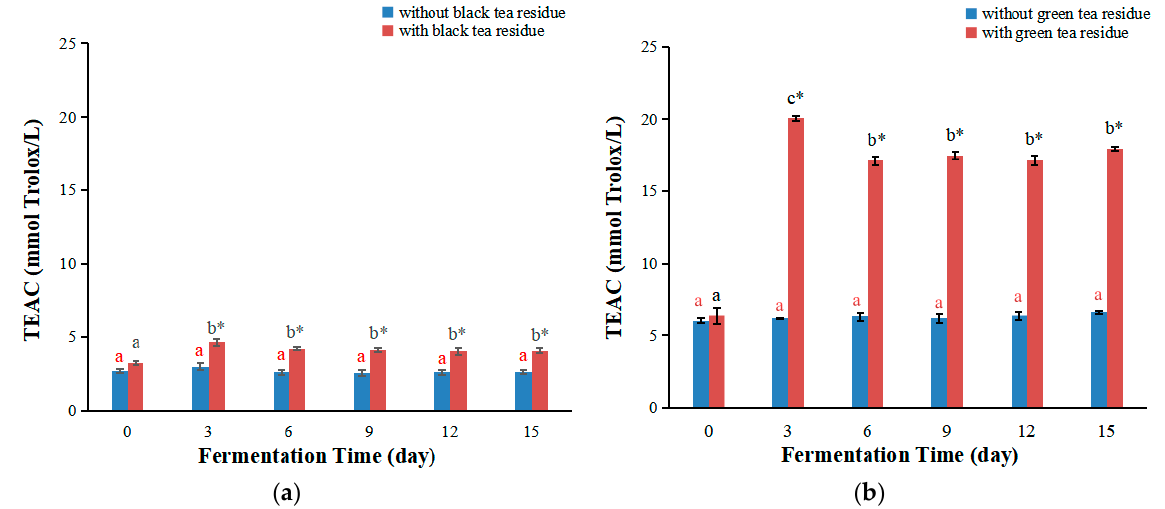
Figure 3. Changes of TEAC values of kombucha produced by fermentation with or without tea residue at different fermentation stages. ( a ) TEAC values of kombucha from black tea; ( b ) TEAC values of kombucha from green tea. Different letters illustrate significant differences ( p < 0.05) for the same kombucha beverage at different fermentation times, and the same letter represents no significant difference ( p > 0.05). Different colors of letters represent different kombucha fermentation with tea residue or without tea residue. * Indicates significant difference ( p < 0.05) between kom- bucha fermentation with tea residue and kombucha fermentation without tea residue at the same fermentation